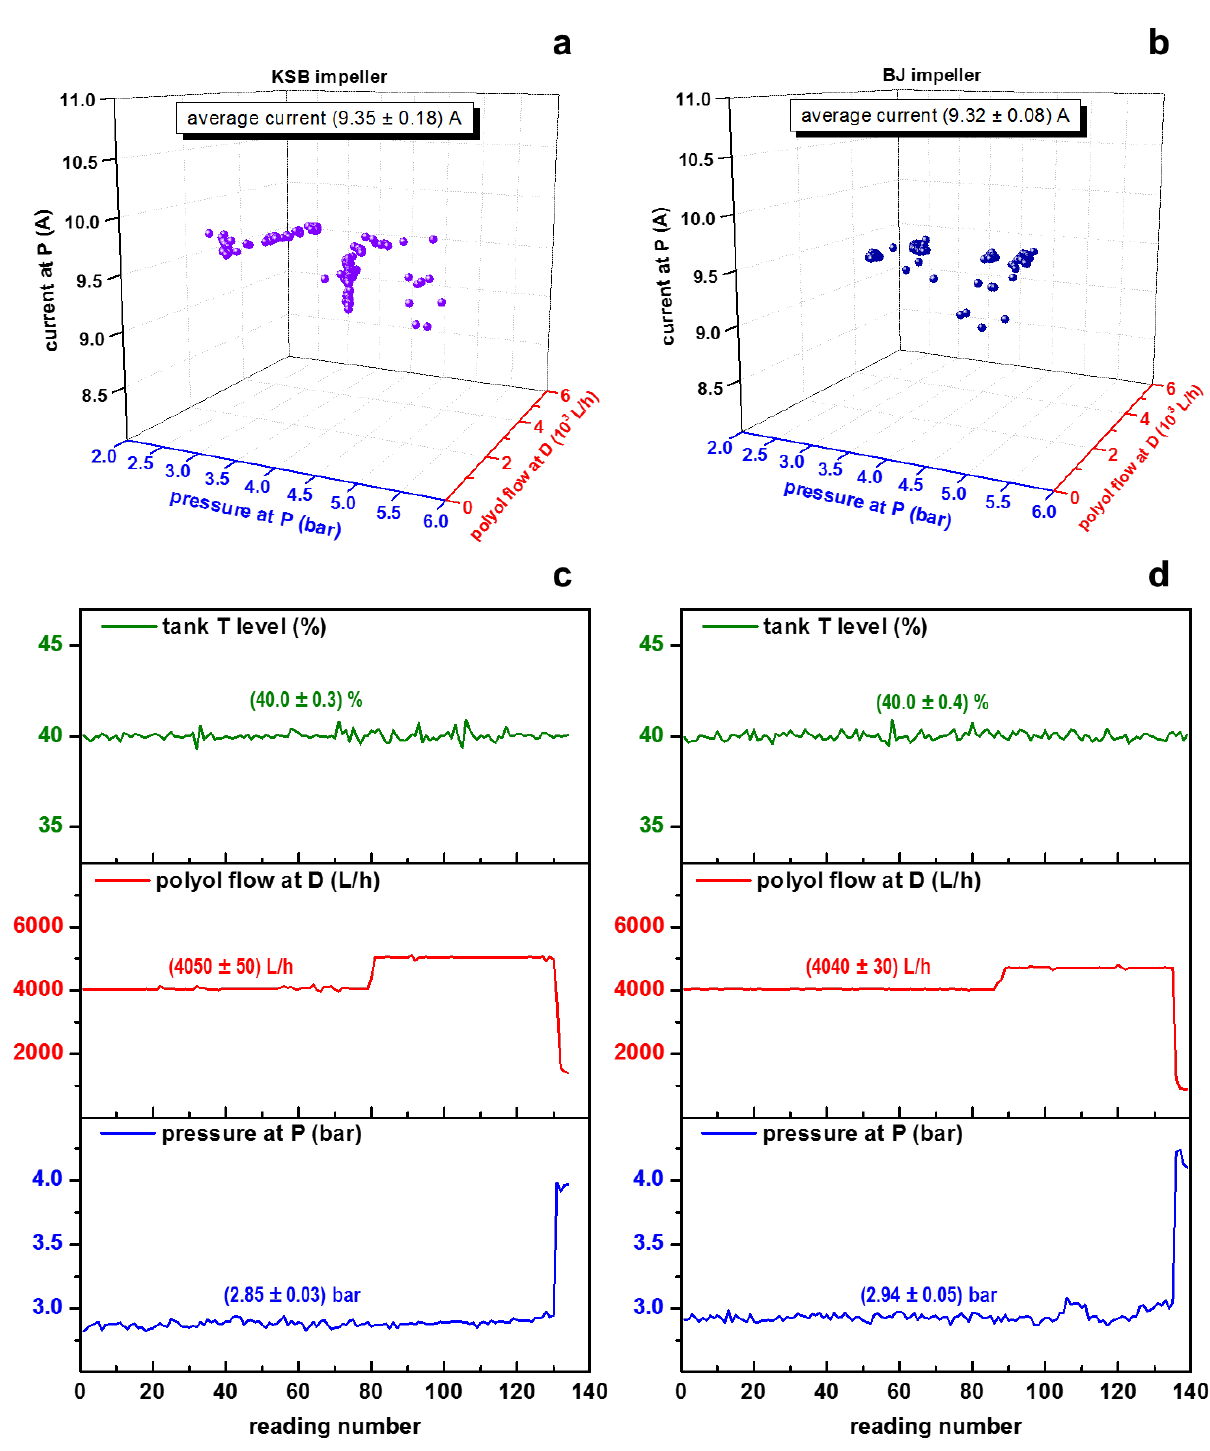
Figure 13. Recipe 3. ( a , b ) Dependence of pump amperage (current) on pump pressure and polyol flow for two consecutive production cycles. ( c , d ) Tank level, polyol flow, and pump pressure, read continuously for a complete production cycle. KSB impeller ( a , c ), BJ impeller ( b , d ).